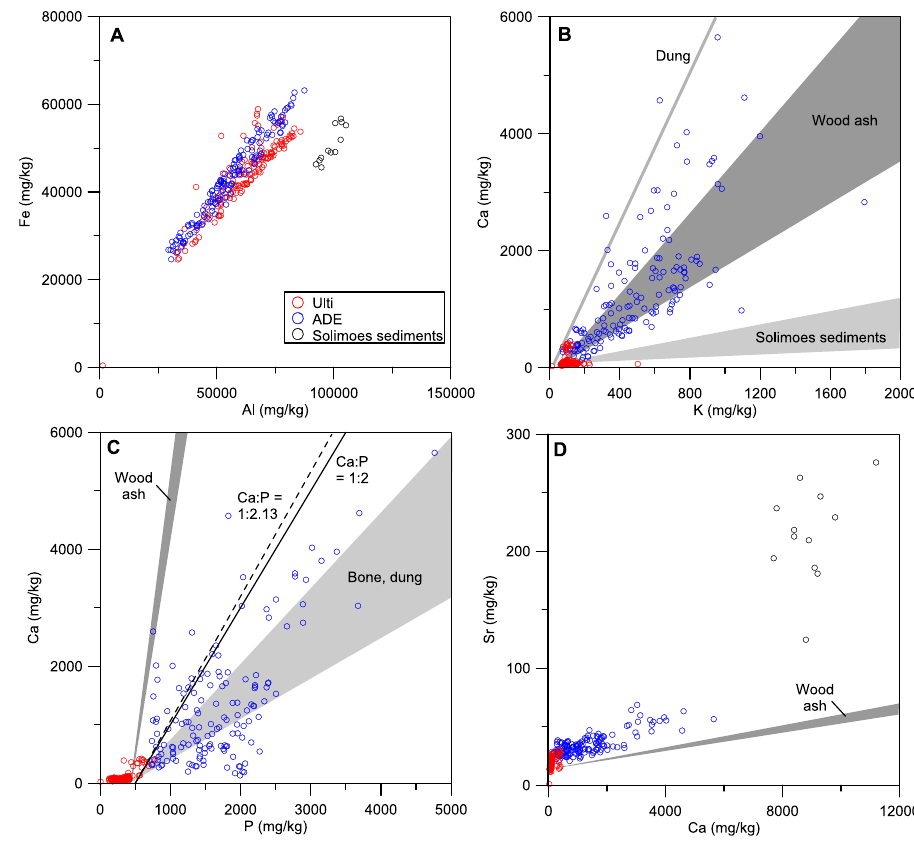
Fig. 1 Caldeirão ’ s soil compositional data compared with published data of Solimões River sediments and anthropic materials. Data is in Supplementary Table 1; the wood ash and bone/dung fi elds in ( C , D ) are offset to compensate for soil (Ulti) background concentrations. ADE = Amazonian Dark Earth, Ulti = Ultisol soil pro fi le. A Geogenic elements Al and Fe are similar in ADE and Ultisols, but different from Solimoes sediments. B , C Anthropogenic elements K, Ca, and P fall in the range of anthropogenic materials. Solimões sediments have much lower Ca/K ratios and far higher K concentrations. Black continuous and broken lines give the 1:2 and 1:2.13 Ca:P ratios quoted by Silva et al. 5 for human faeces and freshwater fi sh, respectively, corrected for 500 mg/kg soil (Ulti) background. D Ca and Sr show strong correlations in ADE. The Ca/Sr ratio in ADE is close to that of wood ash, suggesting an anthropogenic origin for Sr, while Solimões sediments have overall much higher